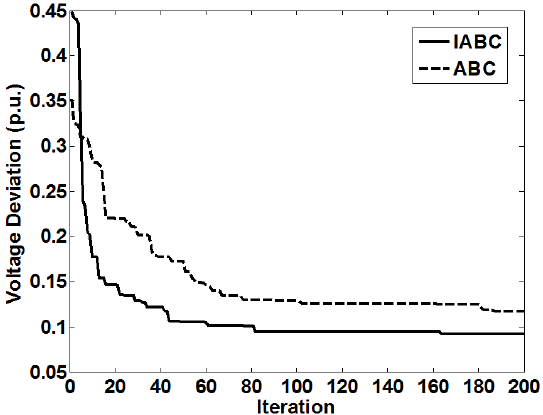
Figure 10. Convergence characteristics of voltage deviation of the IABC and ABC algorithms for the IEEE 30-bus